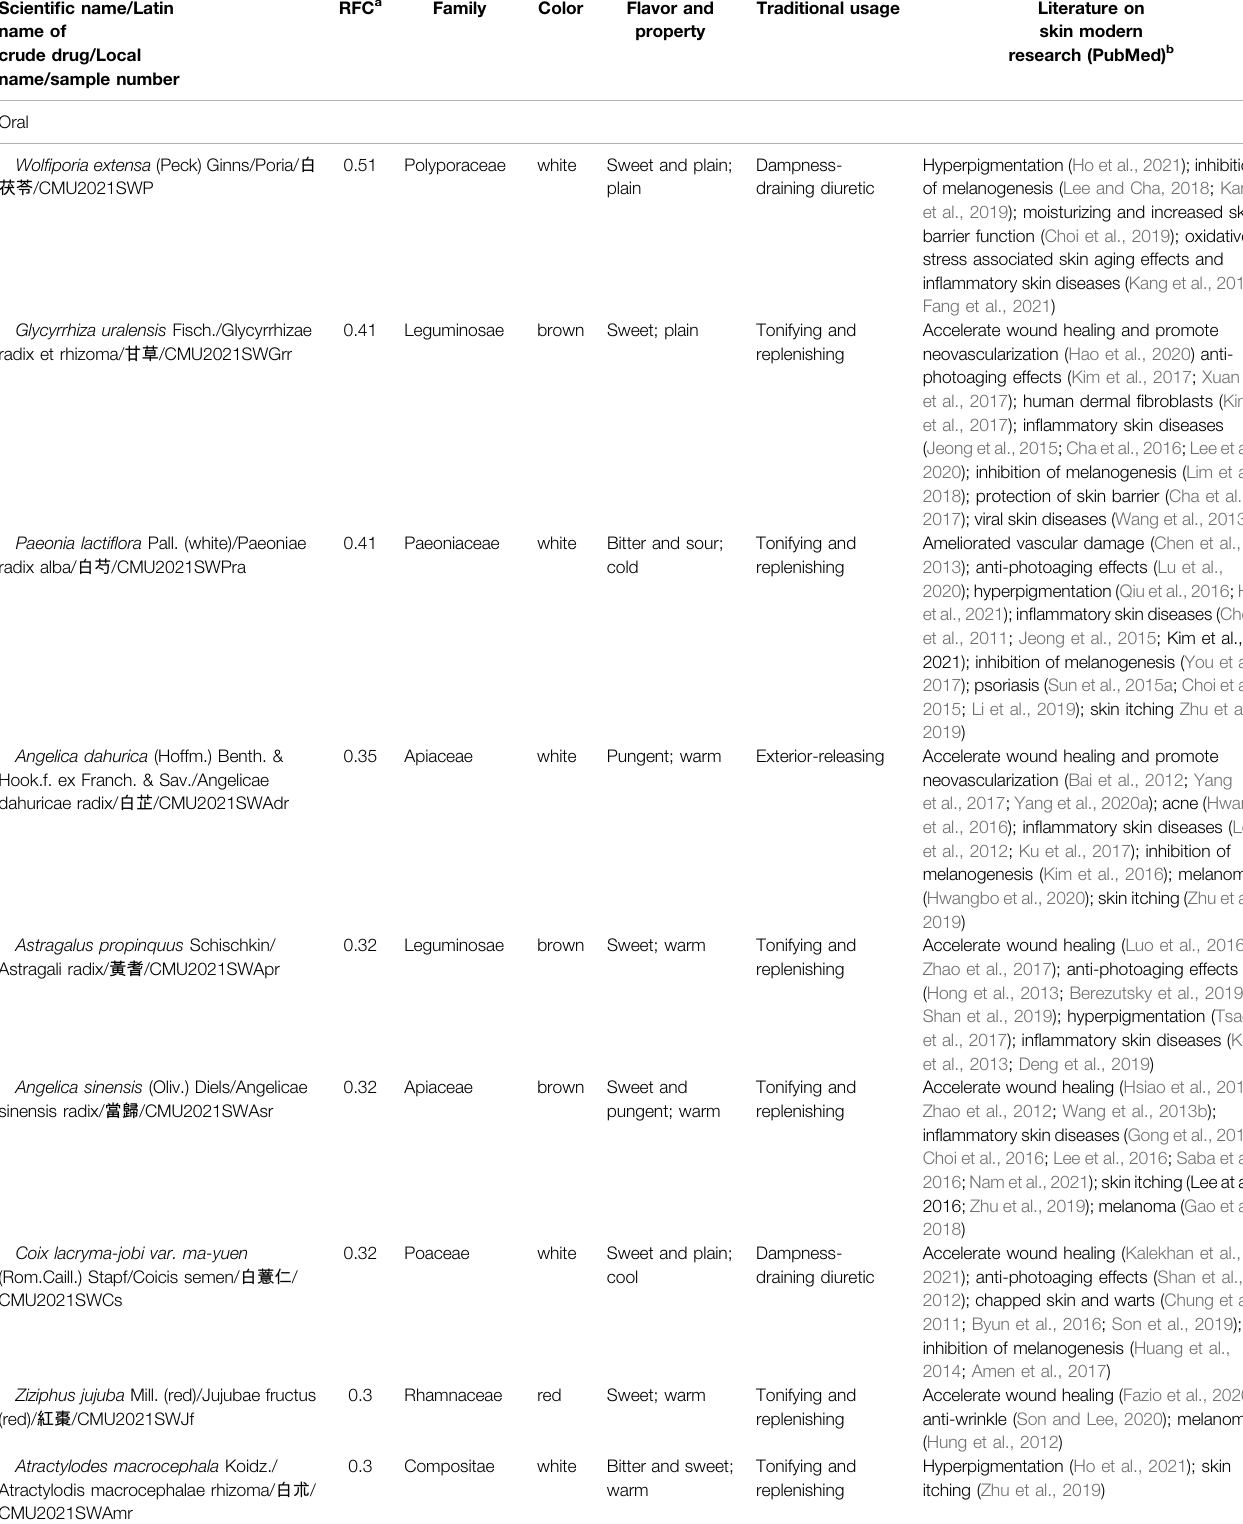
TABLE 2 | Medicinal properties and skin-related modern research of commonly used medicinal materials used in skin whitening prescriptions (RFC > 0.2). Scienti fi c name/Latin name